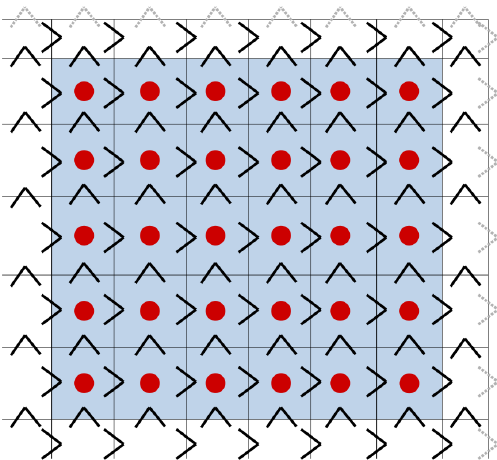
Figure 3. The MPI subdomain is bounded by the grid, the interior of the MPI subdomain is highlighted in blue while the ghost cells 1 are in white. Black arrows show U and V points where η m + 2 (and 1 therefore ˜ U hm + 2 ) can be directly computed and grey arrows point where they cannot be computed without communication. Red dots 1 show T points where div ( ˜ U hm + 2 ) can be directly